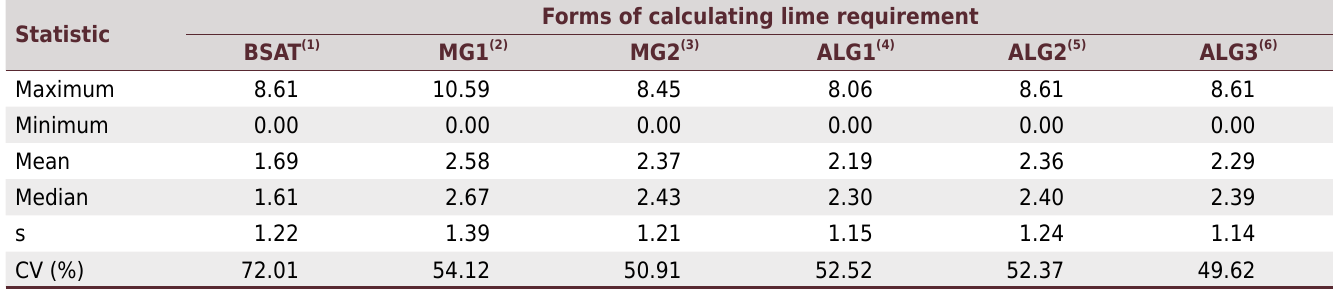
Table 3. Maximum and minimum values, mean, median, standard deviation (s), and coefficient of variation (CV) of lime requirements estimated for six different forms of calculation, for 600 soil samples collected in coffee plantings, in regard to crop requirements and tolerance (V = 60 %, X = 3.5 and m t = 25 %) Forms of calculating lime Statistic